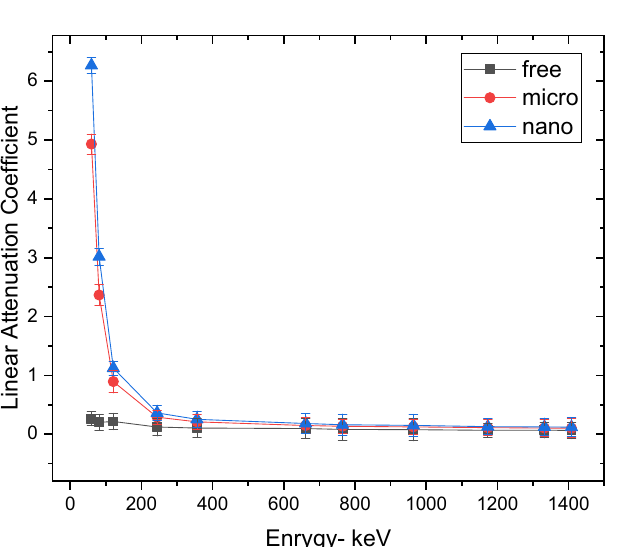
Figure 7. Comparison between LAC for free silicon rubber nano- and micro-SnO 2 for 50wt% at different energy